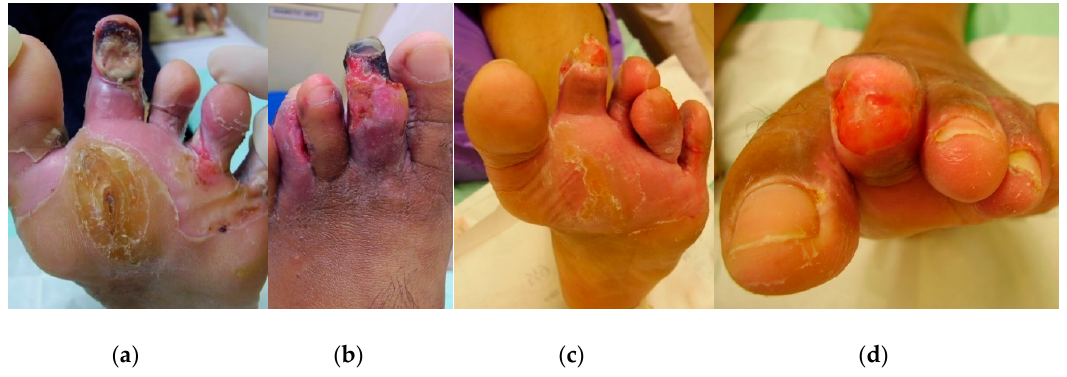
Figure 5. Case 5: ( a ) the wound at the start of MGH therapy (day 0); ( b ) gangrenous toe at day nine that needed amputation; ( c ) advanced healing of the wound after three weeks of MGH therapy; ( d ) wound closure after six weeks of MGH therapy.